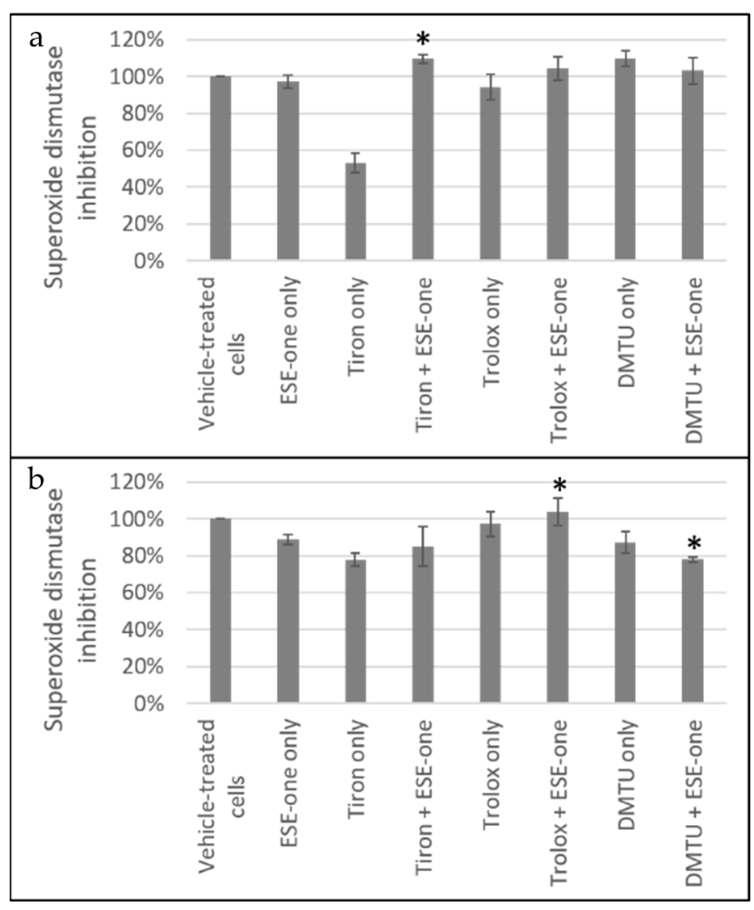
Figure 6. SOD inhibition graphs of ( a ) MCF-7 and ( b ) MDA-MB-231 cells exposed to ESE-one in the presence or absence of scavengers of reactive oxygen species (tiron, trolox and DMTU). Tiron, trolox and DMTU coexposure with ESE-one resulted in an increased SOD inhibition percentage compared to ESE-one only exposure in MCF-7 cells suggesting that increased generation of reactive oxygen species due to ESE-one exposure is not required for the inhibition of SOD. In MDA-MB-231, DMTU demonstrated a decrease in SOD inhibition percentage suggesting that hydrogen peroxide affects the superoxide anion activity. ( a ) MCF-7, ( b ) MDA-MB-231. An asterisk (*) indicates p -value ( p < 0.05) compared to ESE-one treated